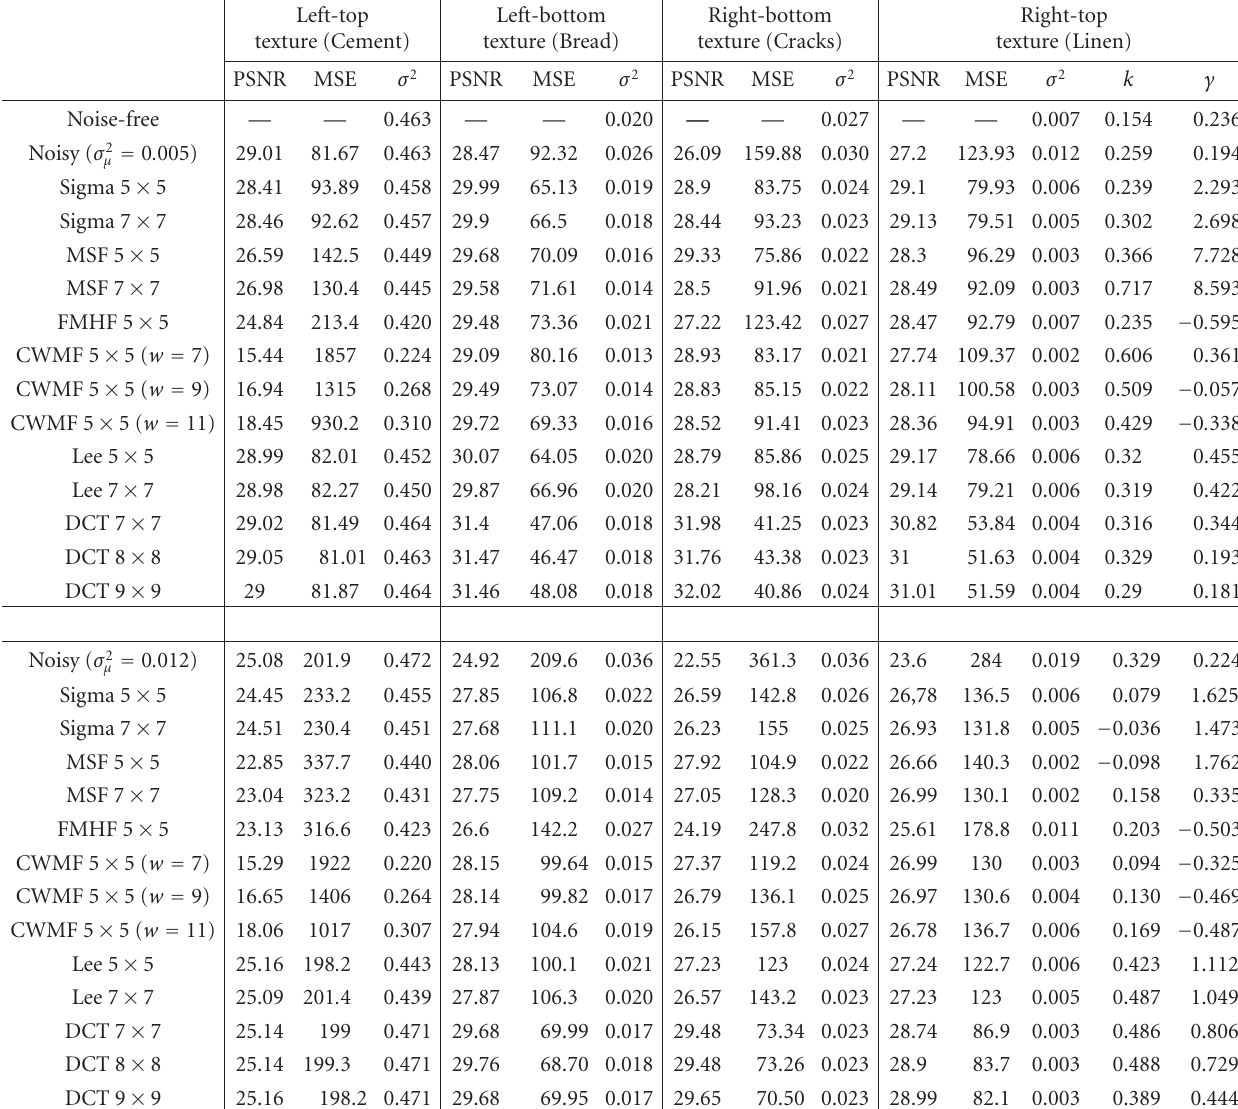
Table 1: Comparative quantitative results of application of di ff erent DPFs to four texture samples corrupted by multiplicative Gaussian noise with σ 2 µ = 0 . 005 and σ 2 µ = 0 .